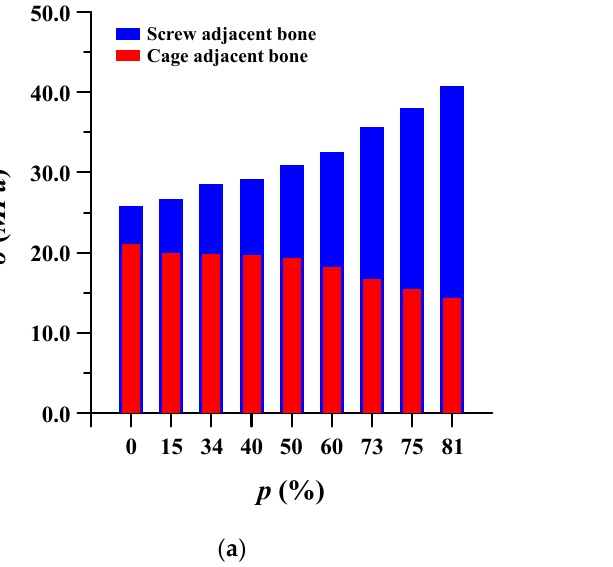
Figure 10. Equivalent stress distribution of adjacent intervertebral disc (IVD) of L5-S1 at spinal implant porosity 0% in each spinal motion: ( a ) flexion; ( b ) extension; ( c ) lateral bending; ( d ) rotation (unit: MPa).